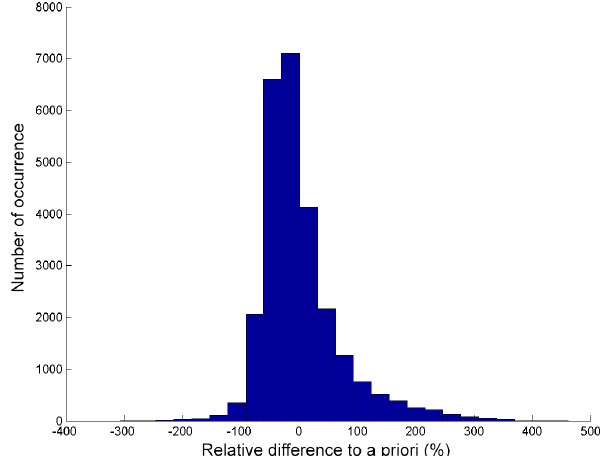
Figure 5. Histogram of the relative differences between the calcu- lated total columns (derived from the (cid:49)T b conversion) and the a priori total columns (used as input in the forward simulations). The a priori total columns are defined as the